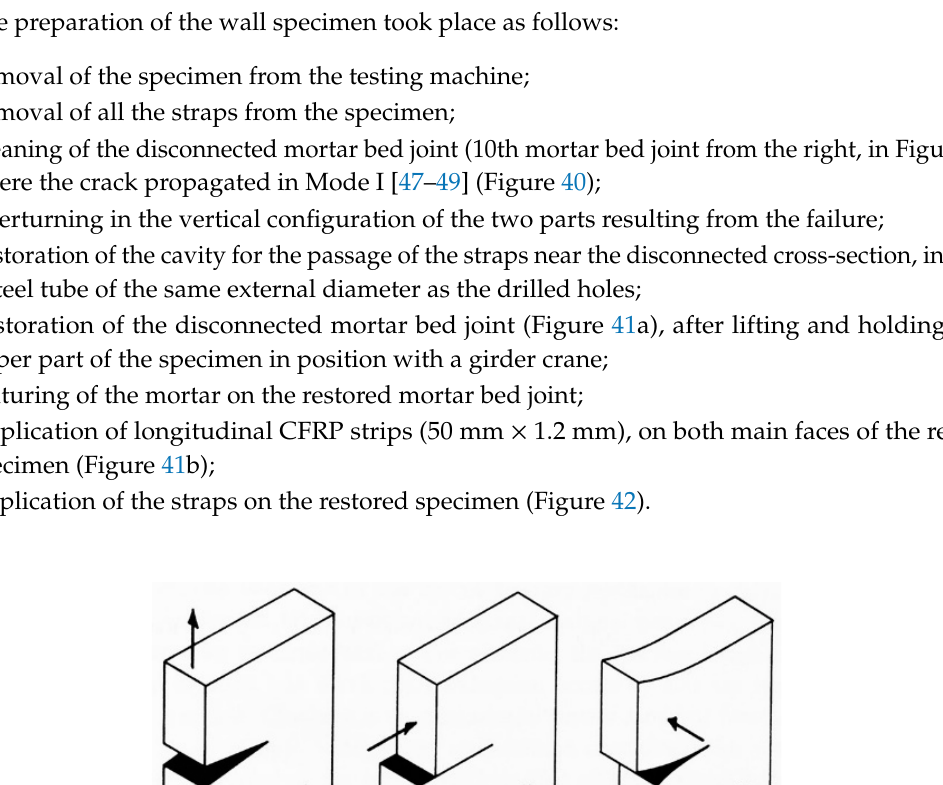
Figure 41. Preparation of the specimen: ( a ) restoration of the 10th mortar bed joint from below (front view) and ( b ) application of the CFRP strips after the maturing period (back view). Figure 42. The four staggered meshes to strap the restored specimen (Specimen W5).